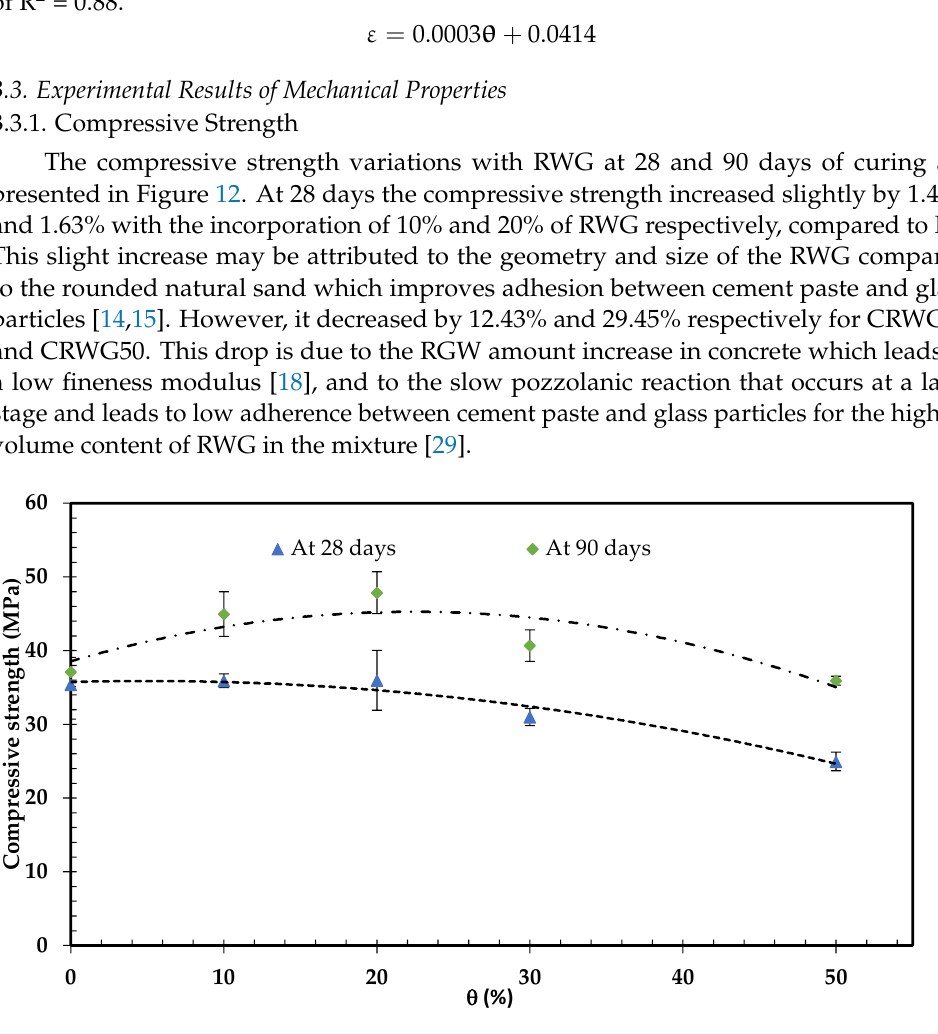
Figure 13. Flexural strength influence of concrete reinforced with different volume percentages of RWG.